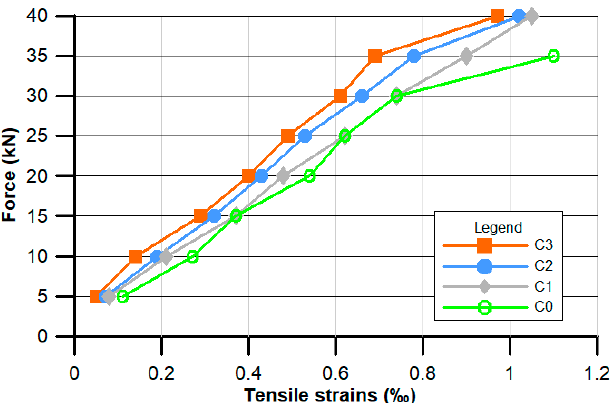
Figure 7. Experimental relationships between concentrated force F and tensile strain 𝜀 .